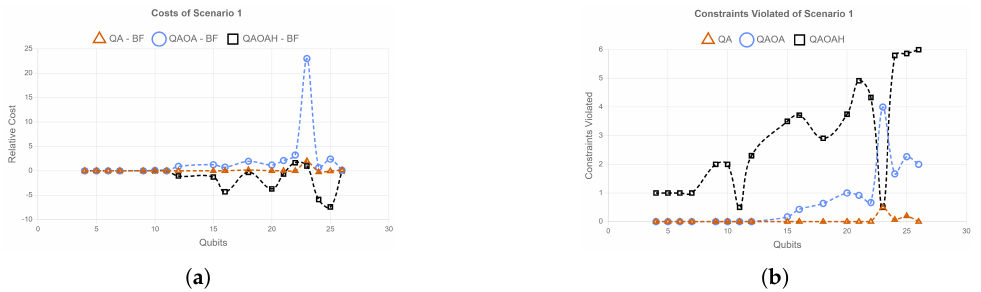
Figure 7. QPU Results ( a ) Average relative cost versus the number of qubits used. The relative cost is the mission plus the precedence cost obtained minus the lowest possible mission plus precedence cost that can be achieved (while keeping constraints) for the problem; the lowest possible cost is found by brute force: Relative cost = algorithm’s solution cost–brute force solution’s cost. Negative relative costs imply that the solution violated constraints. ( b ) Average number of constraints violated versus the number of qubits used. The number of constraints counts up how many extras qubit are on within a column in the matrix view representation. This count includes the number of columns that do not have any qubits on it at